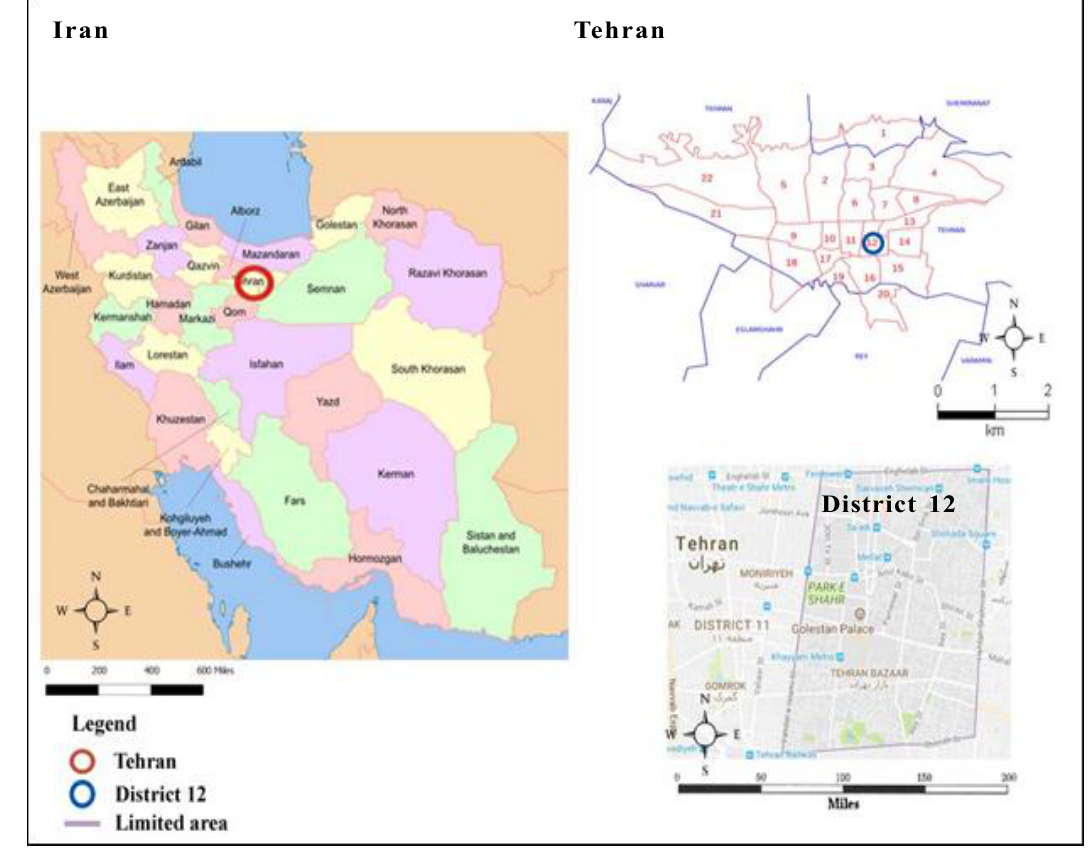
Fig. 1: Map of study area in